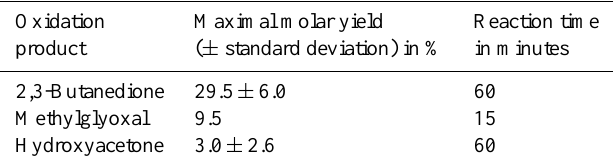
Table 2. Maximal molar yields of the oxidation